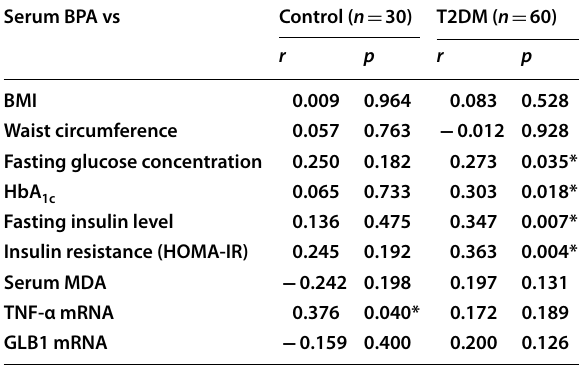
Fig. 4 Box plot showing the comparison between the two studied groups according to the relative expression of TNF-α mRNA ( p Table 4 Correlation between serum BPA with different